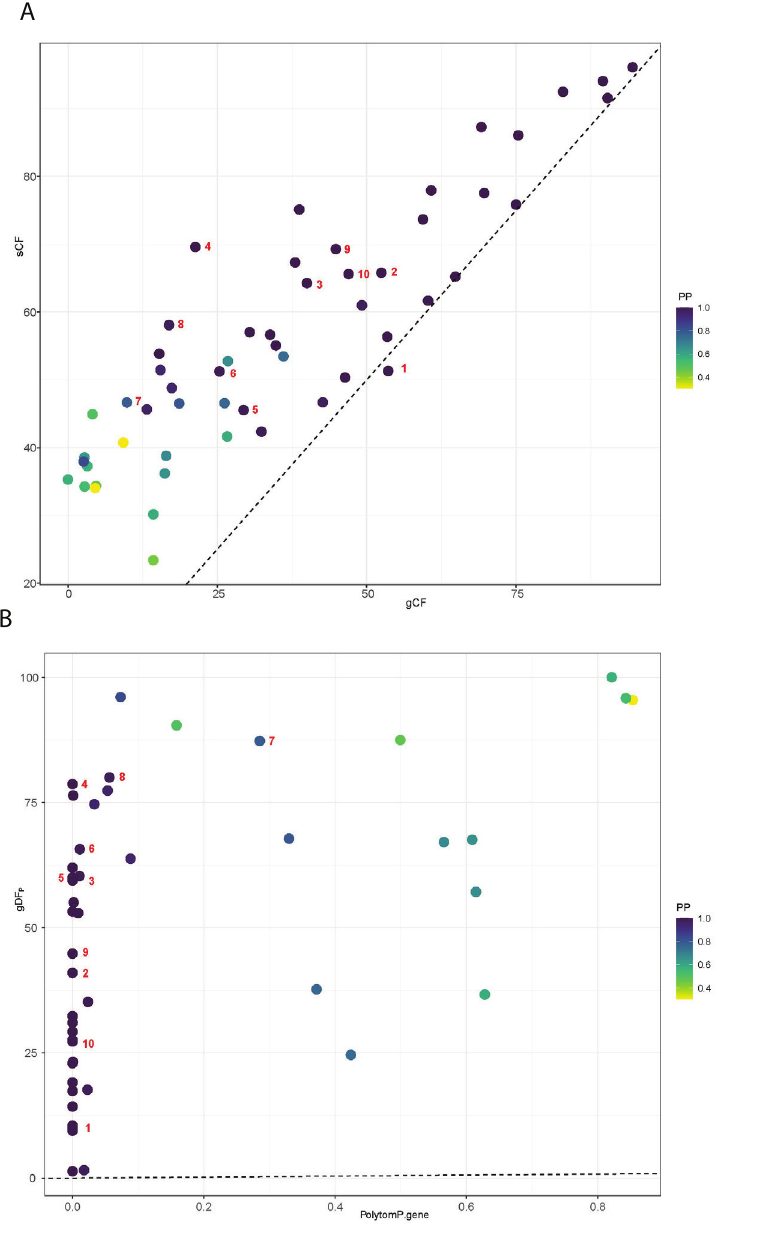
Figure 7. A scatter plot showing PP values and the relationship to gene concordance factors (gCF) and site concordance factors (sCF) (gene tree analysis). The red numbers coincide with the branch numbers of Table 4 and Fig. 3 B scatter plot showing p-value (polytomy test) and the relationship to gene discordance factors (paraphyly) (gDFP). Points show each bipartition in the full dataset phylogeny, with red numbers coinciding with the branch numbers in Fig. 3 and Table